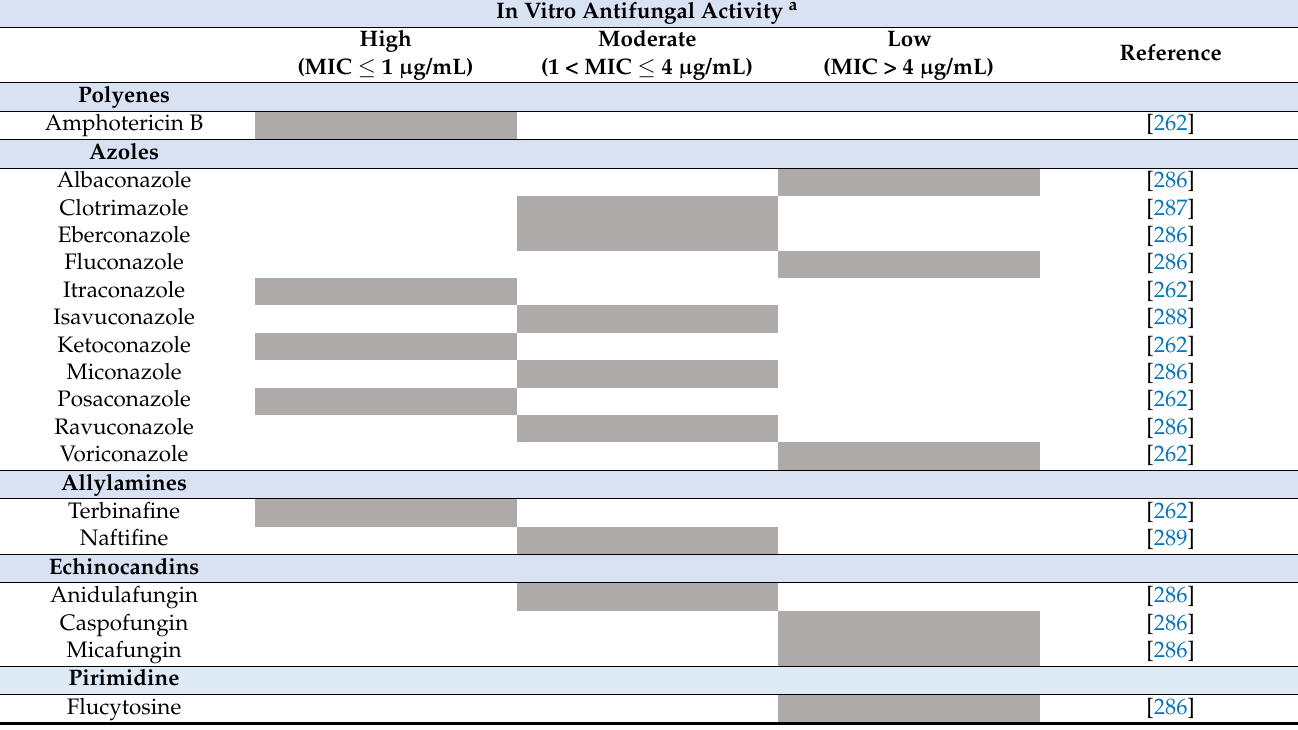
Table 1. In vitro antifungal activity against pathogenic Sporothrix species. In Vitro Antifungal Activity a